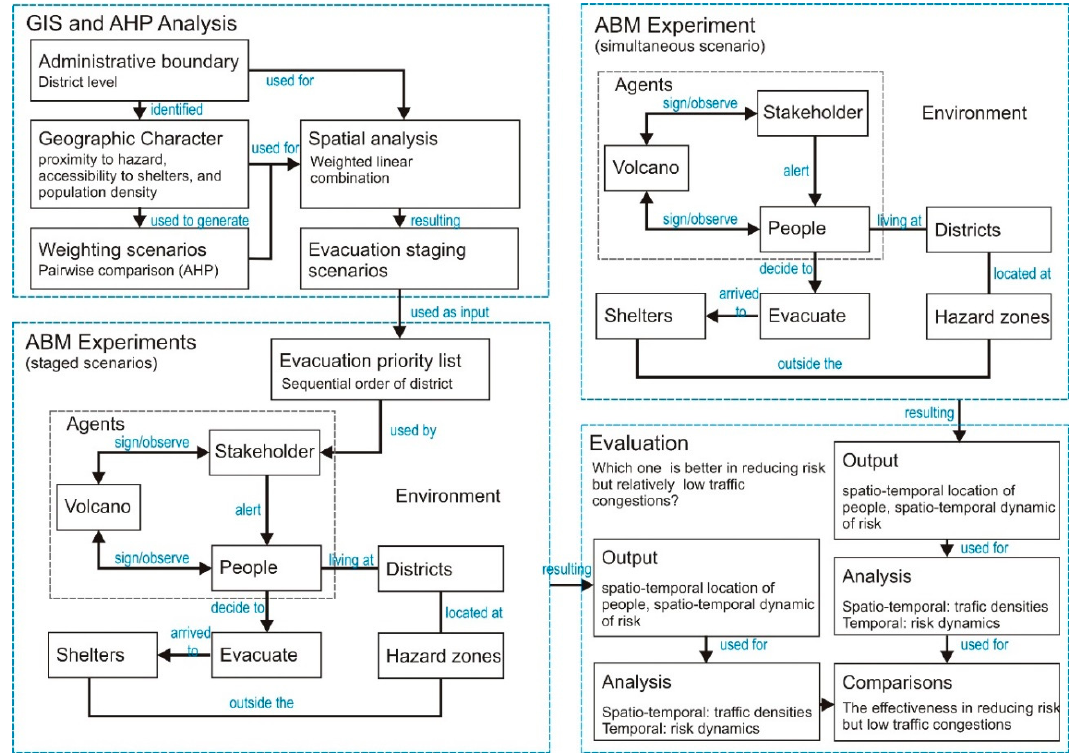
Figure 1. The general framework.